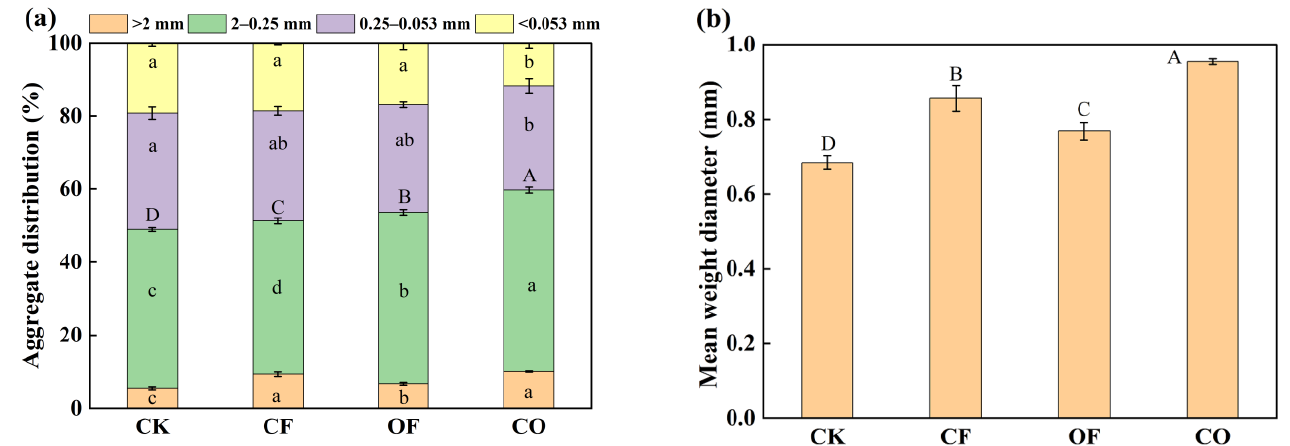
Figure 1. Soil aggregate distribution ( a ); mean weight diameter of aggregate ( b ) under different fertilization treatments. ( a ) Different lowercase letters show significant differences between treatments for the same aggregate size ( p < 0.05), while different uppercase letters indicate significant differences of >0.25 mm fraction proportion among fertilization treatments ( p < 0.05). ( b ) Different uppercase letters indicate significant differences among fertilization treatments ( p < 0.05). Values are means ± SE ( n = 3). CK, no fertilizer; CF, chemical fertilizer; OF, organic fertilizer; CO, chemical fertilizer (50% N) plus organic fertilizer (50%